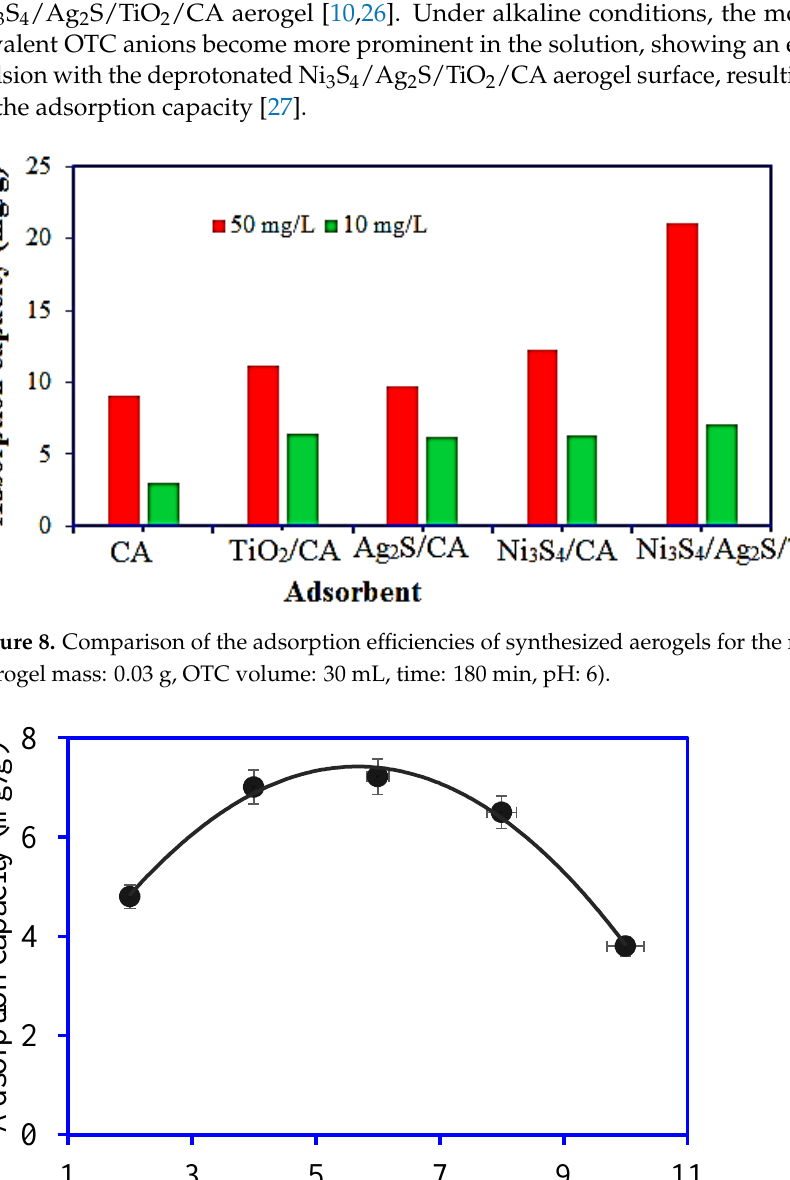
nitrogen, sulfur-containing functional groups on OTC molecules and